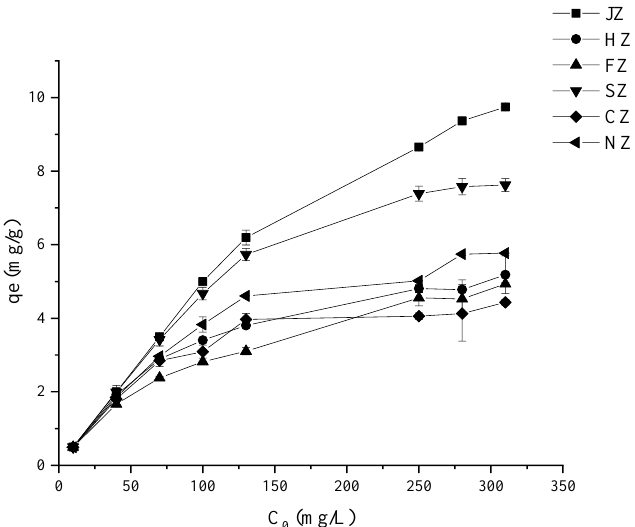
Figure 4. Curve presenting zeolite adsorption at different concentrations of Cd solution.